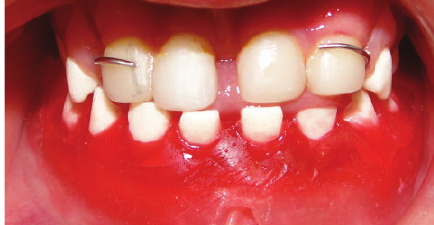
Figure 9: Wax try-in of the maxillary and mandibular dentures.